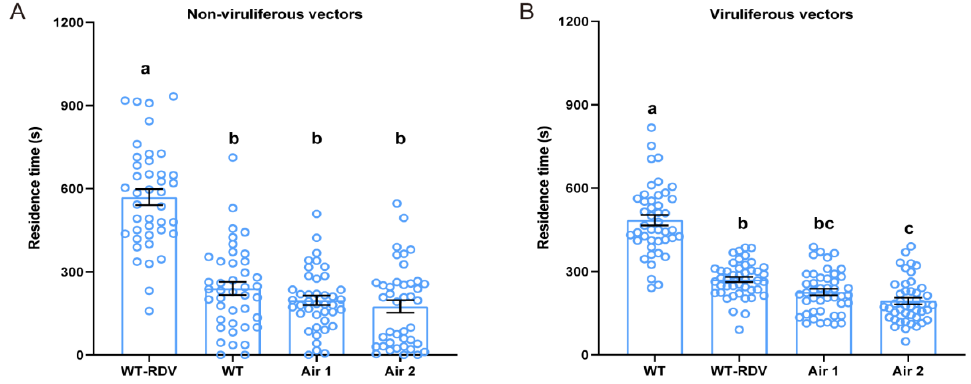
Figure 1. Feeding preference of non-viruliferous ( A ) and viruliferous N. virescens ( B ) between WT and WT-RDV rice plants. RDV, rice dwarf virus; WT, wild type (Minghui63, MH63) (RDV-free); WT-RDV, MH63-RDV (RDV-infected). All feeding choice assays were performed with fifteen biological replicates, each of the fifteen new emergent adults. The statistical differences between the two treatments in the same column were indicated by asterisks (* p < 0.05; ** p < 0.01, Wilcoxon’s signed-ranks tests). Data are mean ± standard error.